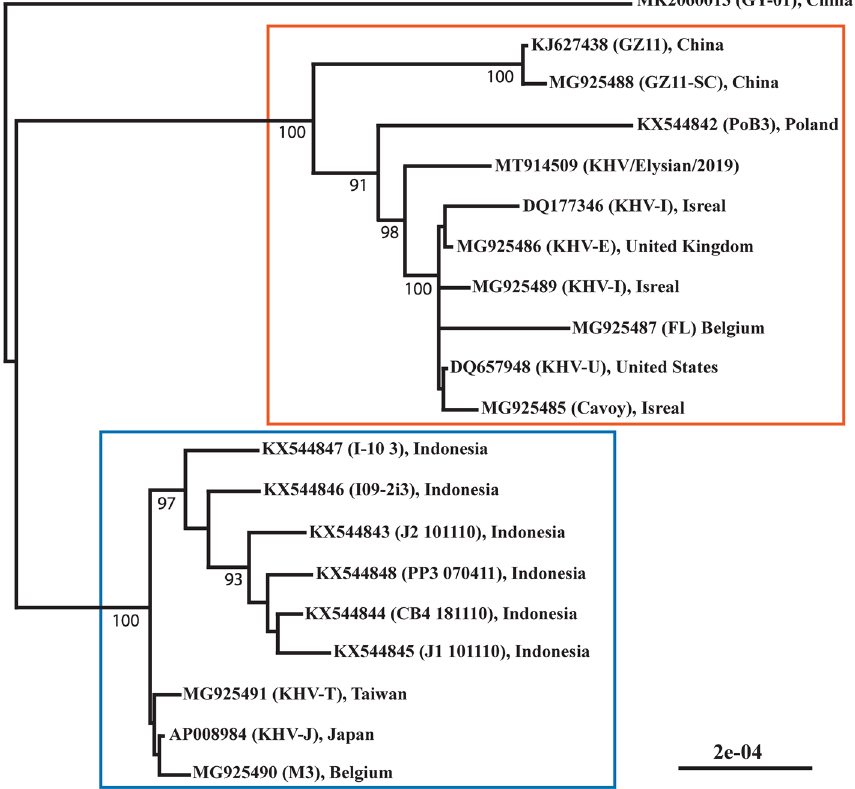
Figure 4. Midpoint-rooted maximum likelihood phylogeny of publicly available CyHV-3 genomes and KHV/ Elysian/2019. The scale bar represents substitutions per site. Genotypes are indicated by vermillion (European) and blue (Asian)